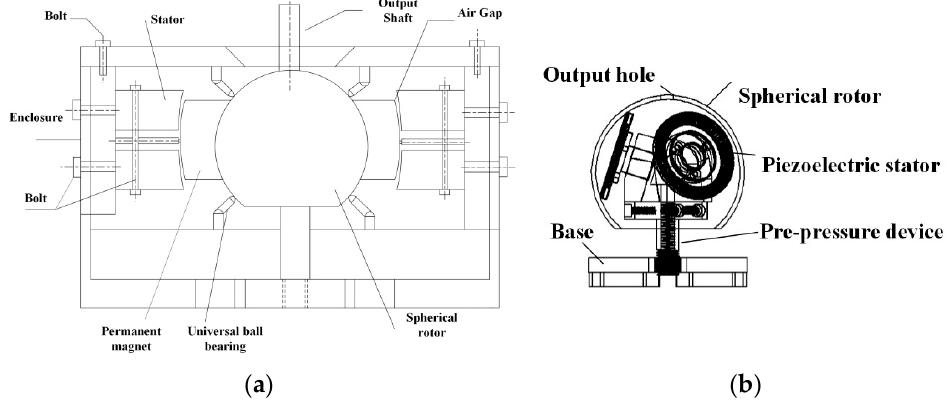
Figure 14. Machining drawing: ( a ) the electromagnetic part and ( b ) the piezoelectric part.